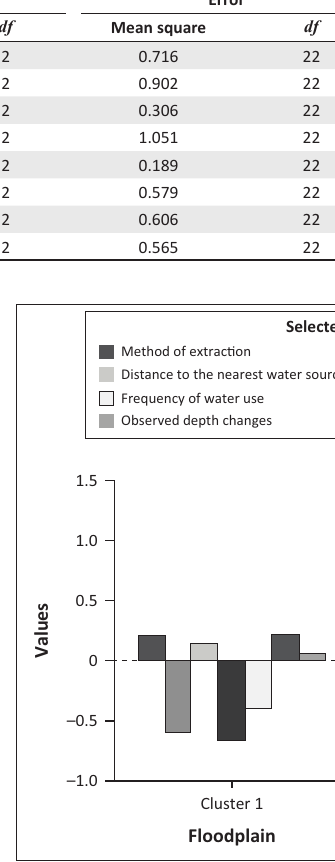
FIGURE 7: (a & b) Turbidity issues in selected sand mining sites. TABLE 2: ANOVA test results associated with K -means clustering. Variables